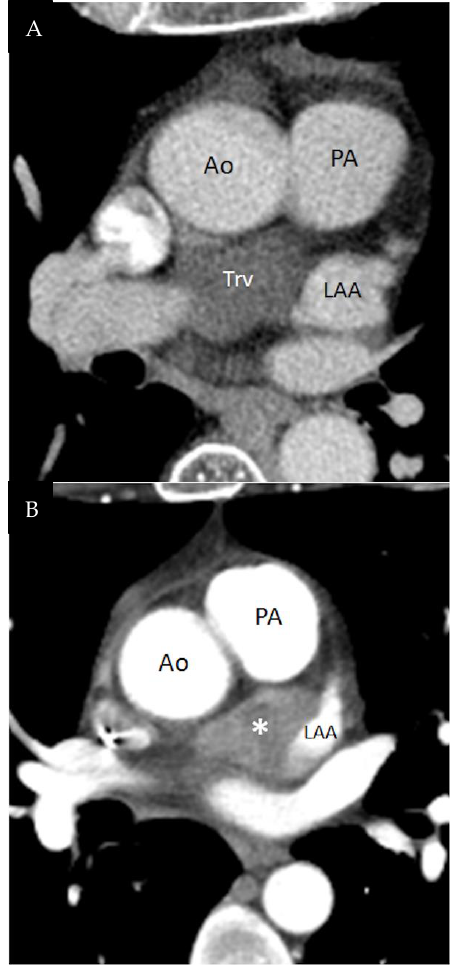
Figure 2. Fluid versus metastatic disease in the transverse sinus. ( A ) A 63 year-old woman with hemophilia. Contrast-enhanced axial CT at a level just inferior to the right pulmonary artery shows fluid in the transverse sinus (Trv). ( B ) A 42 year-old man with melanoma. Contrast-enhanced axial CT shows heterogeneously enhancing soft tissue representing pericardial metastatic disease (*) in the transverse sinus. Soft tissue attenuation and enhancement help distinguish adenopathy or metastatic disease from recess fluid. Ao = ascending aorta, LAA = left atrial appendage, PA = pulmonary artery. Reprinted from Shroff G.S. et al. Pitfalls in oncologic imaging of the pericardium on CT and PET/CT